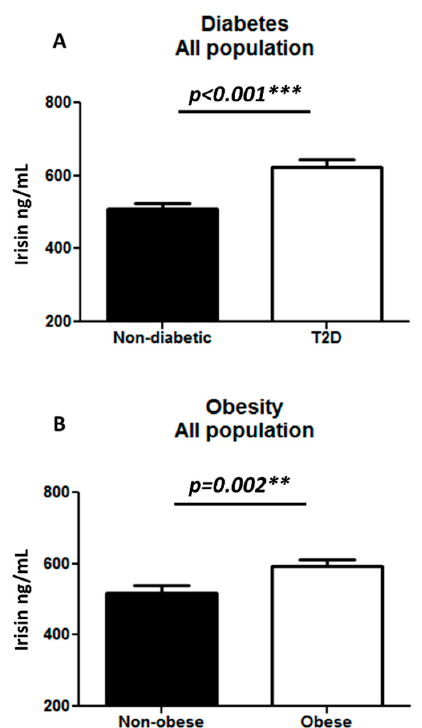
Figure 3. Irisin level in plasma in all populations (n = 228). ( A ) Comparing non-diabetic to T2D individuals; ( B ) comparing non-obese to obese individuals (n = 228). Irisin level in plasma was determined using enzyme linked immunosorbent assay. The population was classified on the basis of their diabetic status ( A ). Diabetes was defined by fasting plasma glucose ≥ 126 mg / L (7 mmol / L). Furthermore, the population was classified on the basis of obesity ( B ). Obesity was defined based on BMI, where participants with BMI > 30 kg / m 2 were considered obese and those with BMI between 20 and 30 kg / m 2 were considered non-obese. Statistical assessment was 2-sided and considered statistically significant at ** p < 0.01; *** p < 0.001